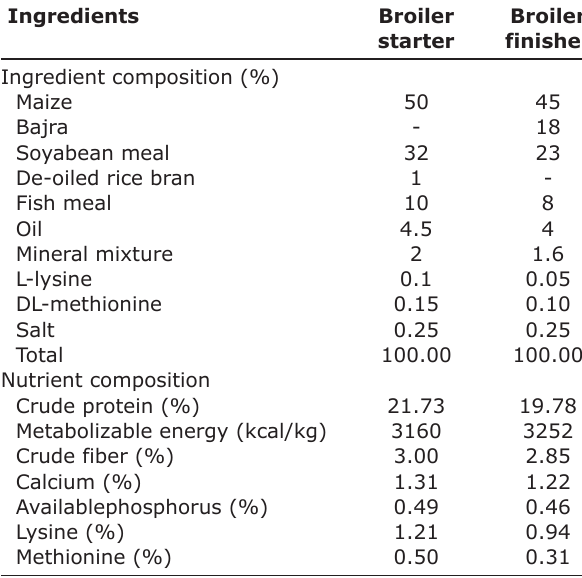
Table-3: Product yield, particle size, zeta potential and mineral content in nano forms of zinc, copper and selenium,